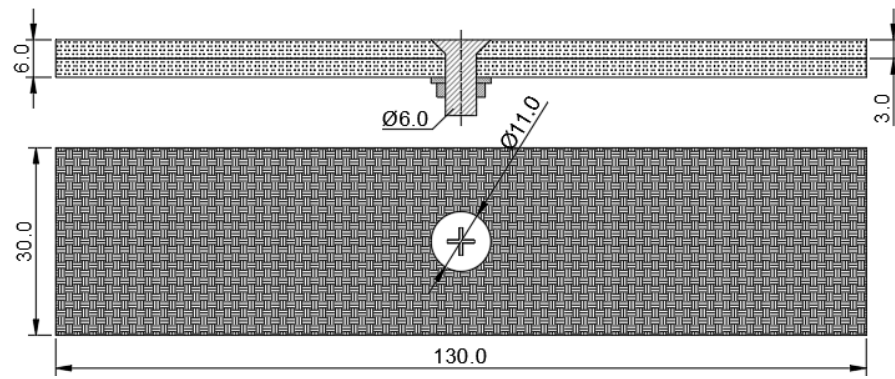
Figure 2. Countersunk bolt laminate specimen (Units: mm).